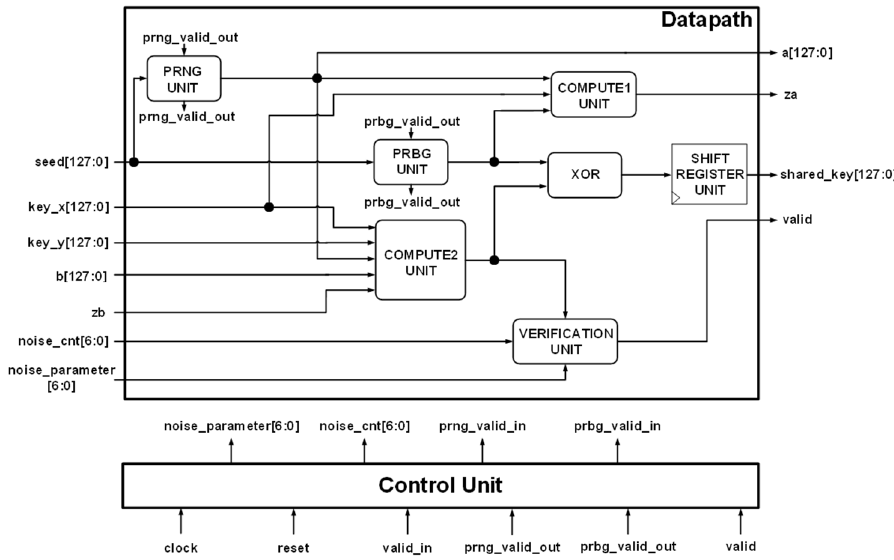
Figure 10. Proposed hardware architecture for the lightweight key exchange protocol.